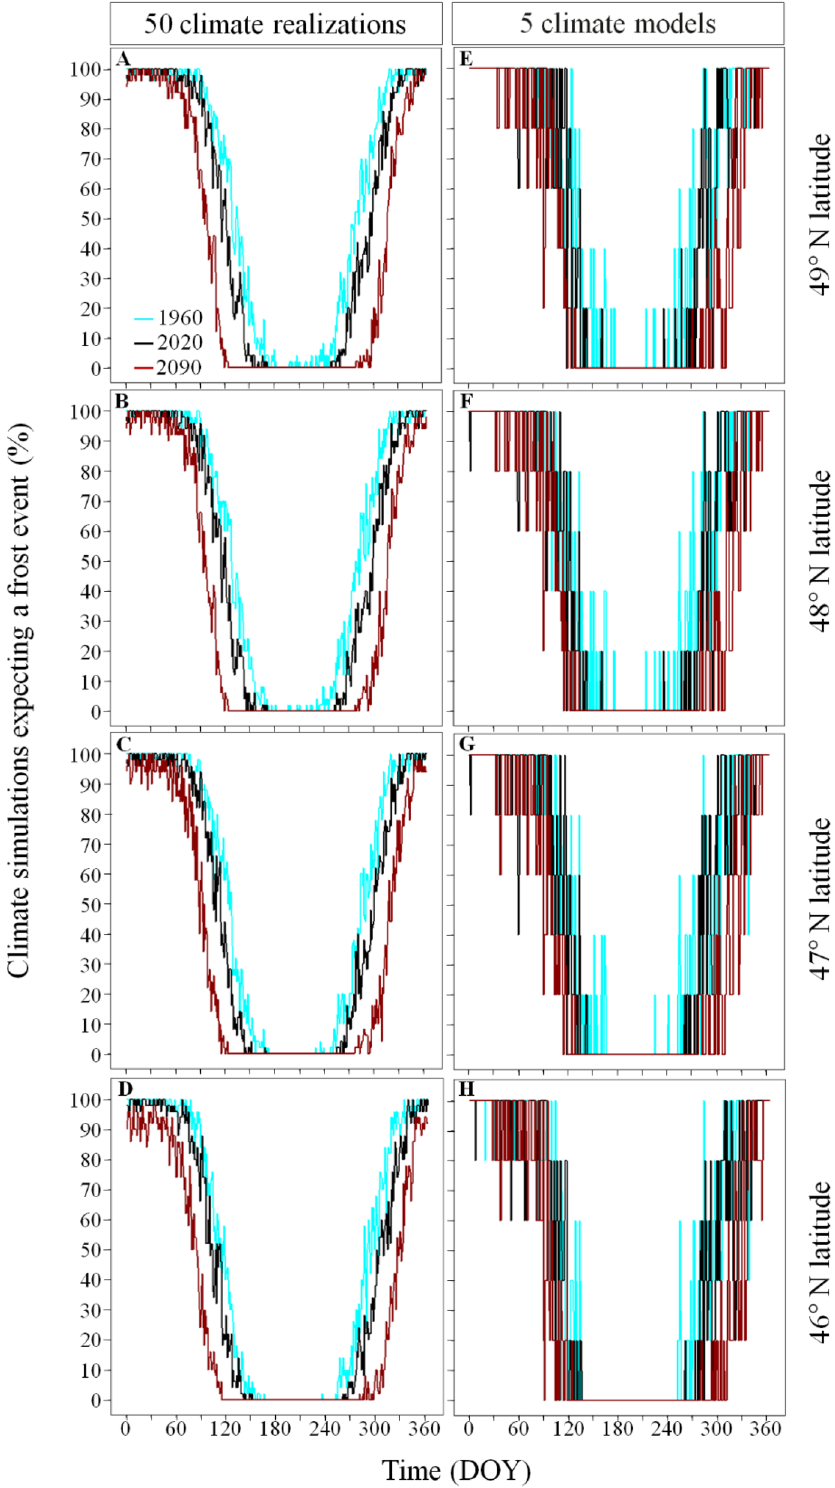
Figure 2. Percentage of climate simulations predicting a frost event per day of year along the latitudinal gradient for three specific years (1960, 2020, 2090). The columns show the results of the intra- and inter- climate model analyses and the rows identify specific grid cells along the latitudinal gradient (46.08, − 77.53; 47.07, − 77.33; 48.21, − 77.40; 49.01, − 77.44 for the intra-climate model analysis: and 46.09, − 77.28; 47.05, − 77.59; 48.17, − 77.50; 49.03, − 77.17 for the inter-climate model). We used the ggplot2 library developed by Wickham 27 to produce the